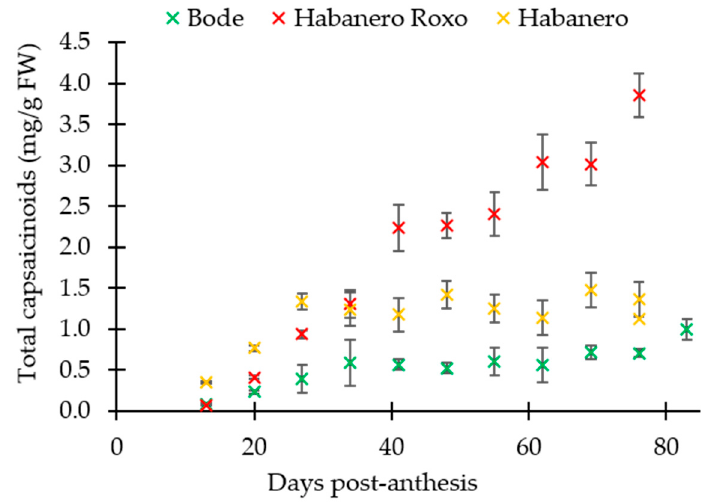
Figure 1. Evolution of total capsaicinoids (mg g − 1 ) in Capsicum chinense Jacq. cultivars over the ripening process. Results are presented as mean ± SD ( n = 3).